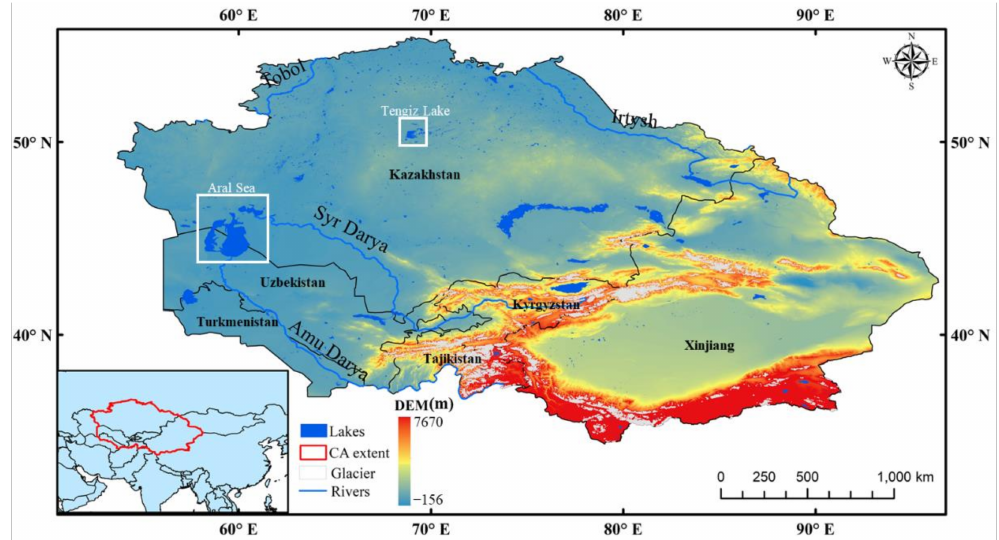
Figure 1. The extent of Central Asia overlayed with a digital elevation model (DEM), glaciers, main rivers, and vectorized lakes from the HydroLAKES dataset